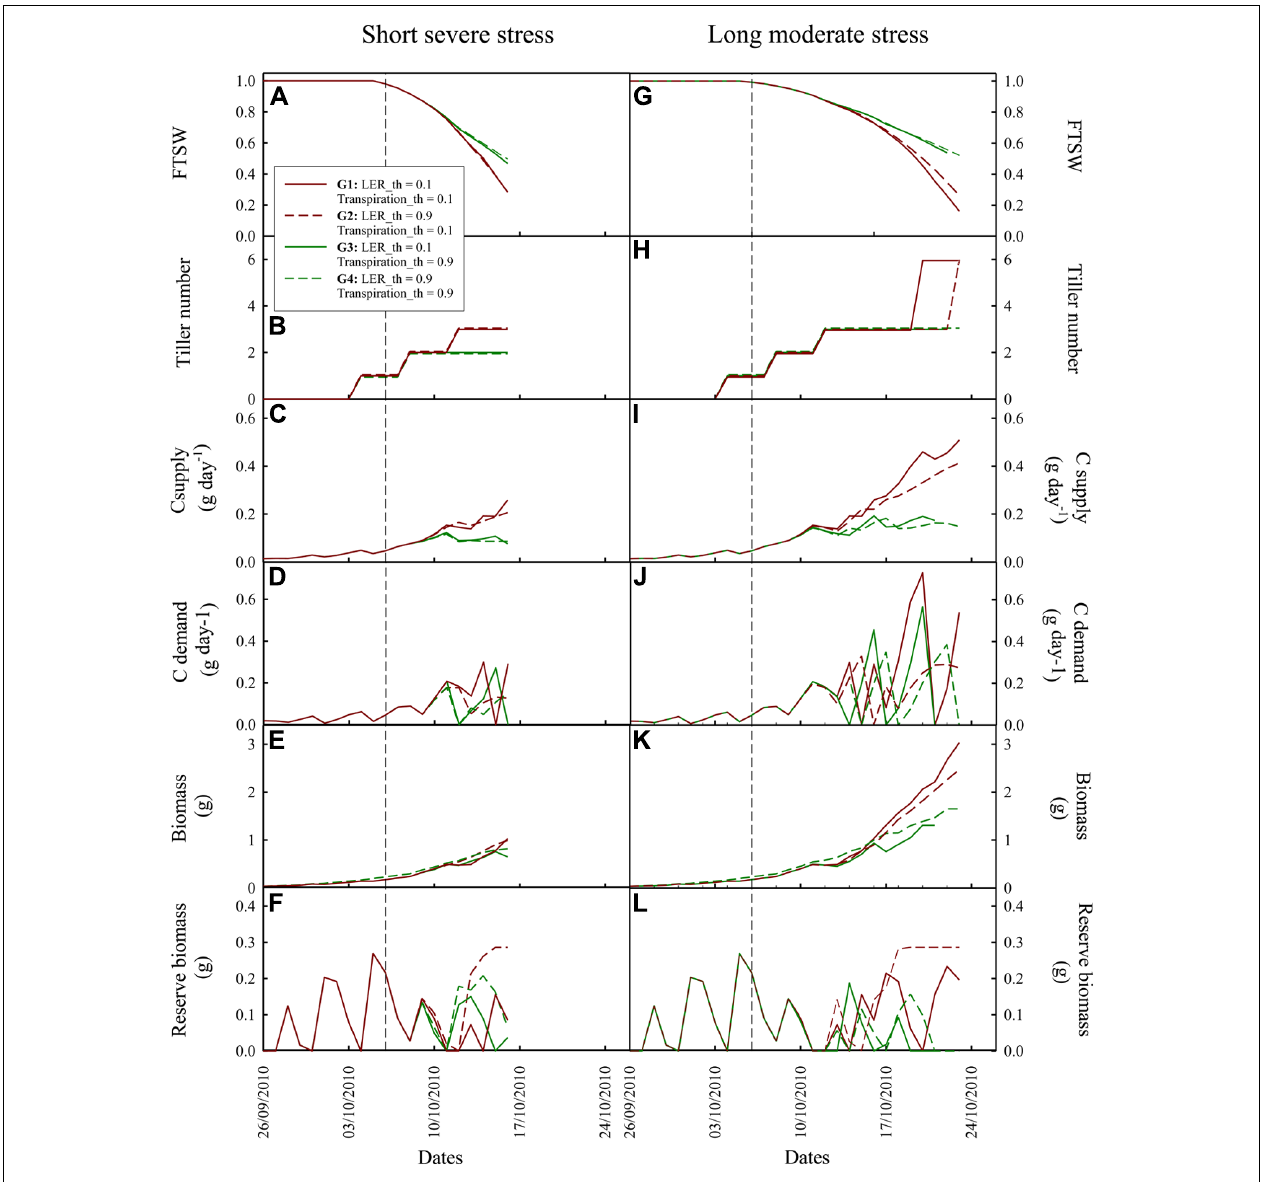
FIGURE 5 | Dynamic simulation by Ecomeristem of four rice genotypes contrasting for leaf expansion rate and leaf transpiration sensitivity to drought. (A–F) : under a short severe dry-down from 20 to 31 days after germination with an evaporative demand of 1.85 mm; (G–L) : under a longer